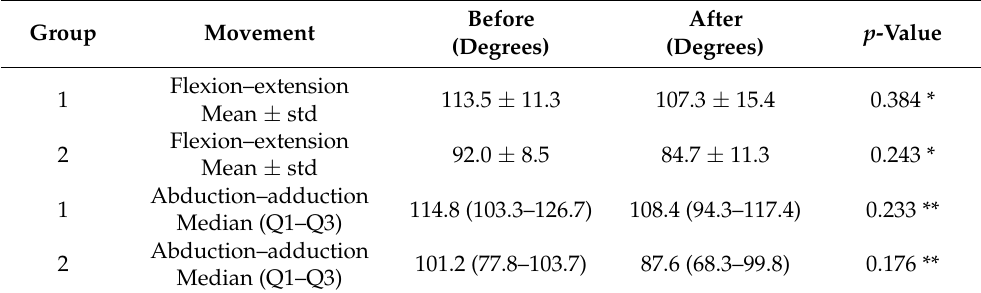
Table 3. Comparison of the range of motion of the glenohumeral joint before and after mastectomy. Group 1, women who did not receive chemotherapy before mastectomy; Group 2, women who received chemotherapy before